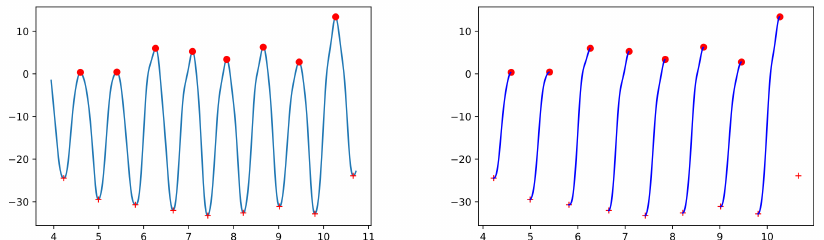
Figure A5. Flexion–extension of the left shoulder in a HC participant, fast walking experiment. ( left ) flexion–extension movements between second 4 and 11. ( right ) amplitude as difference between connected “+” and “o” values.